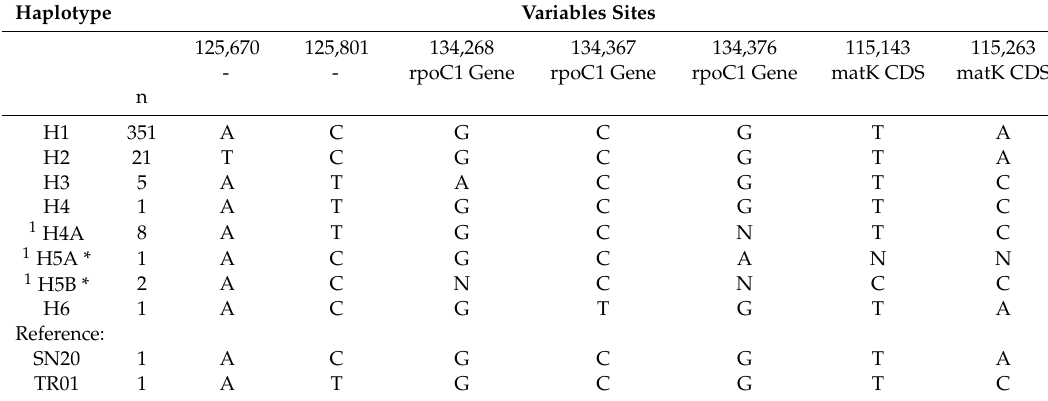
Table 5. Haplotypes recovered from mapping ddRADseq reads to two reference Sclerolaena napiformis cpDNA genomes, SN20 and SnTR1 (151,530 bases long, 814 variable sites in total between the